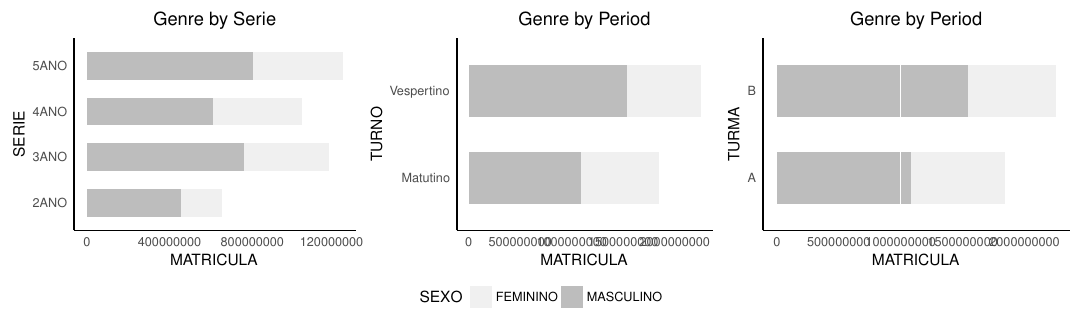
Figure 16. The distribution on the internal organization.